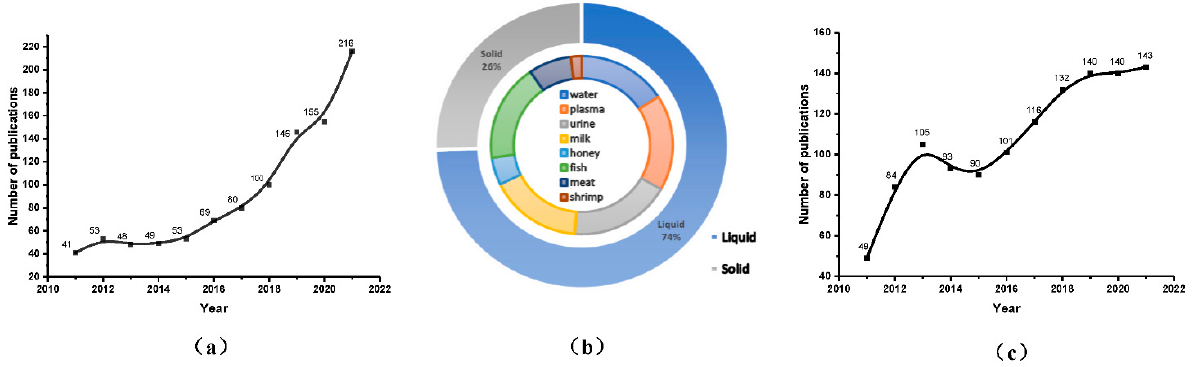
Figure 4. ( a ) The trend of multiresidue detection of antibiotics in last decade. ( b ) The application and trend of on-line solid-phase extraction in different matrixes. ( c ) The trend of using the on-line SPE-LC-MS method in detection of antibiotics in last decade.